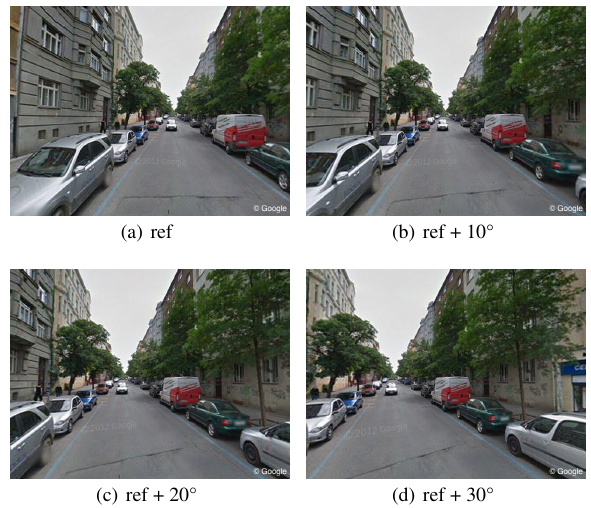
Figure 2. Four consecutive images with the sliding window method, obtained by repeatedly offsetting the camera heading by an angular step of 10° on the GSV